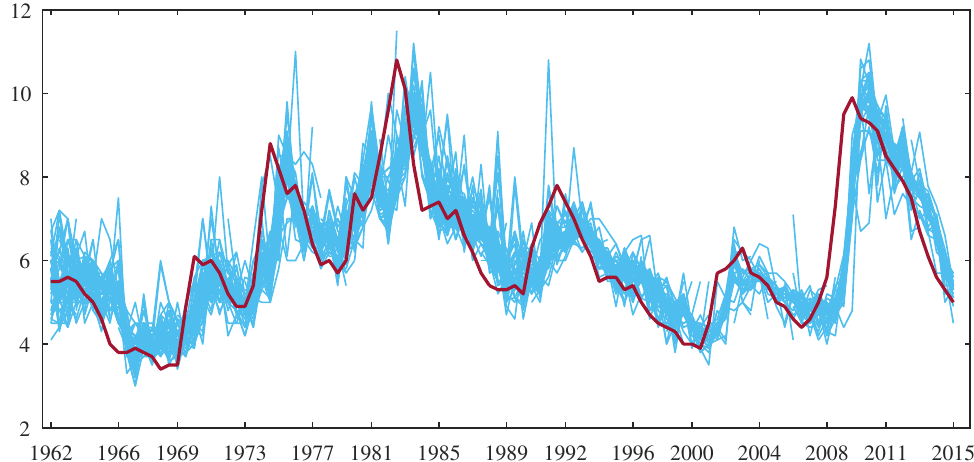
Figure 1. Forecasts of the US unemployment rate 12 months ahead from the Survey of Professional Forecasters (SPF). The thin light blue lines are the predictions from the forecasters, and the thick dark red line is the realized unemployment rate. Data were obtained from: